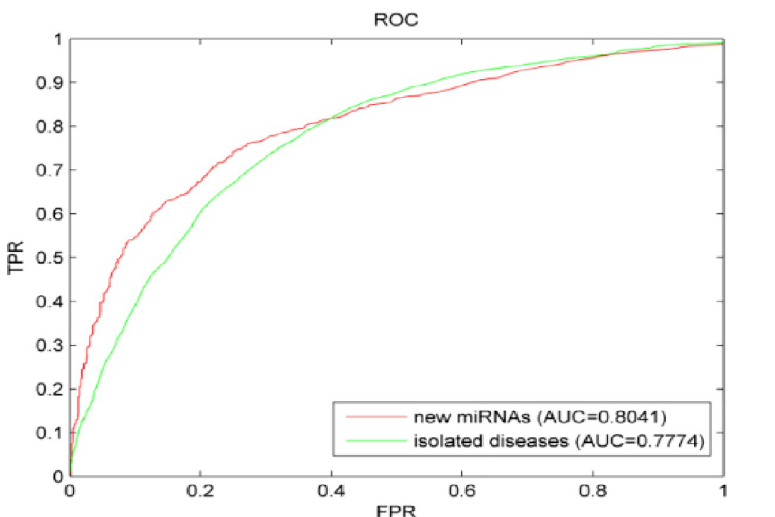
Fig 4. Predictions of new miRNAs and isolated